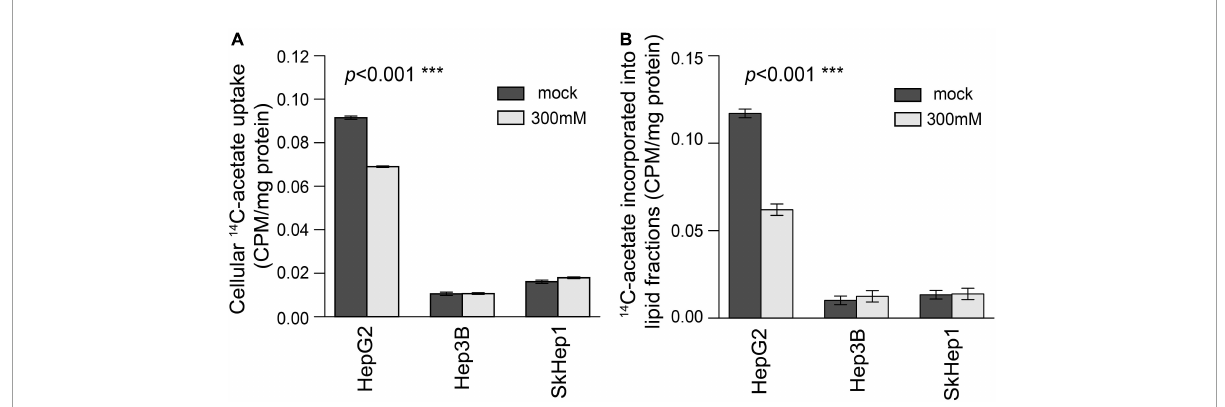
FIGURE4 Treatment response to orlistat treatment assessed using 14 C-acetate uptake and 14 C-acetate incorporated lipid fractions in three HCC cell lines. In HepG2 cells, (A) 14 C-acetate uptake and (B) 14 C-acetate incorporated lipid fractions were significantly inhibited by orlistat treatment (labeled by light gray) compared with mock treatment (labeled by dark gray) (permutation test *** p < 0.001 in both A,B ; n = 6 for each bar). However, orlistat-induced inhibition was not significant in Hep3B and SkHep1 (permutation test p = 0.236 and 0.630, respectively; n = 6 for each bar). 14 C-acetate uptake ( β counter) in cells normalized by protein weight (CPM/mg protein). We summarized these measurements as bar plots that label the averaged values with error bars presenting the standard deviation ( ± 1 SD) computed from six replicates for each treatment ( n = 6 for each bar).